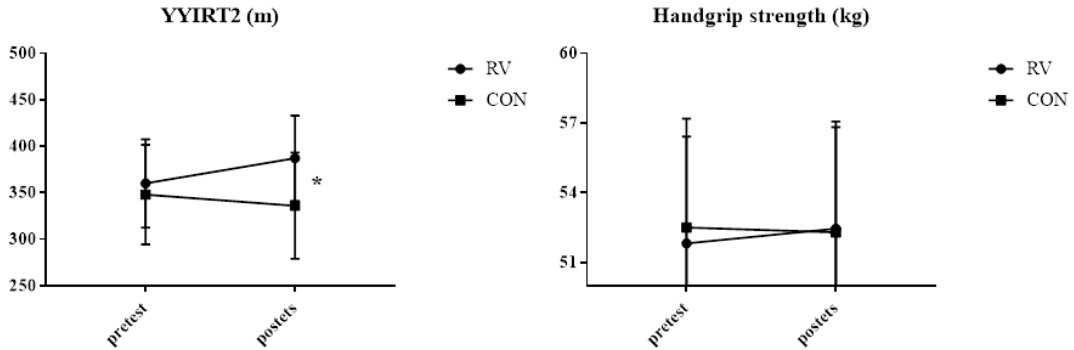
Figure 1. Physical fitness pre-post results. Abbreviations: YYIRT2, Yo-Yo intermittent recovery test–level 2; RV, recreational volleyball group; CON, control group; *, significant interaction between group and time p <